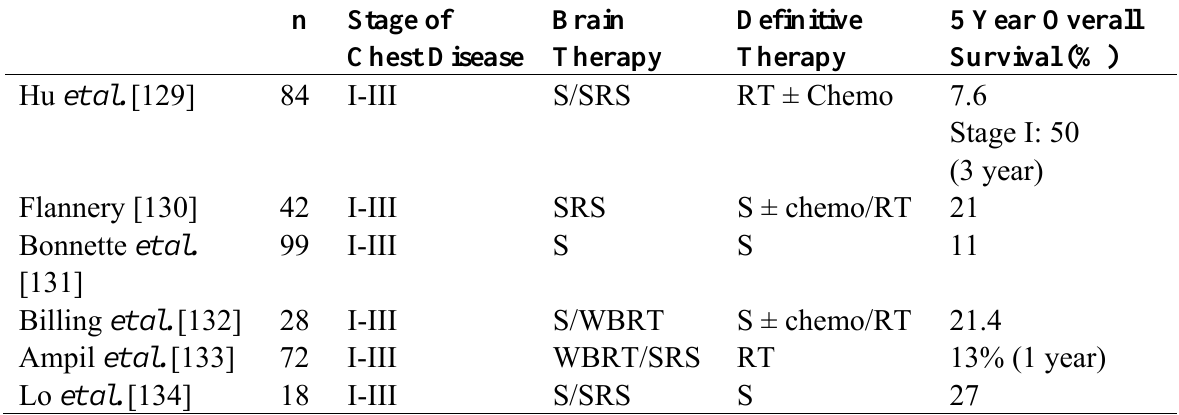
Table 9. Survival outcome from definitive therapy in patients with solitary brain